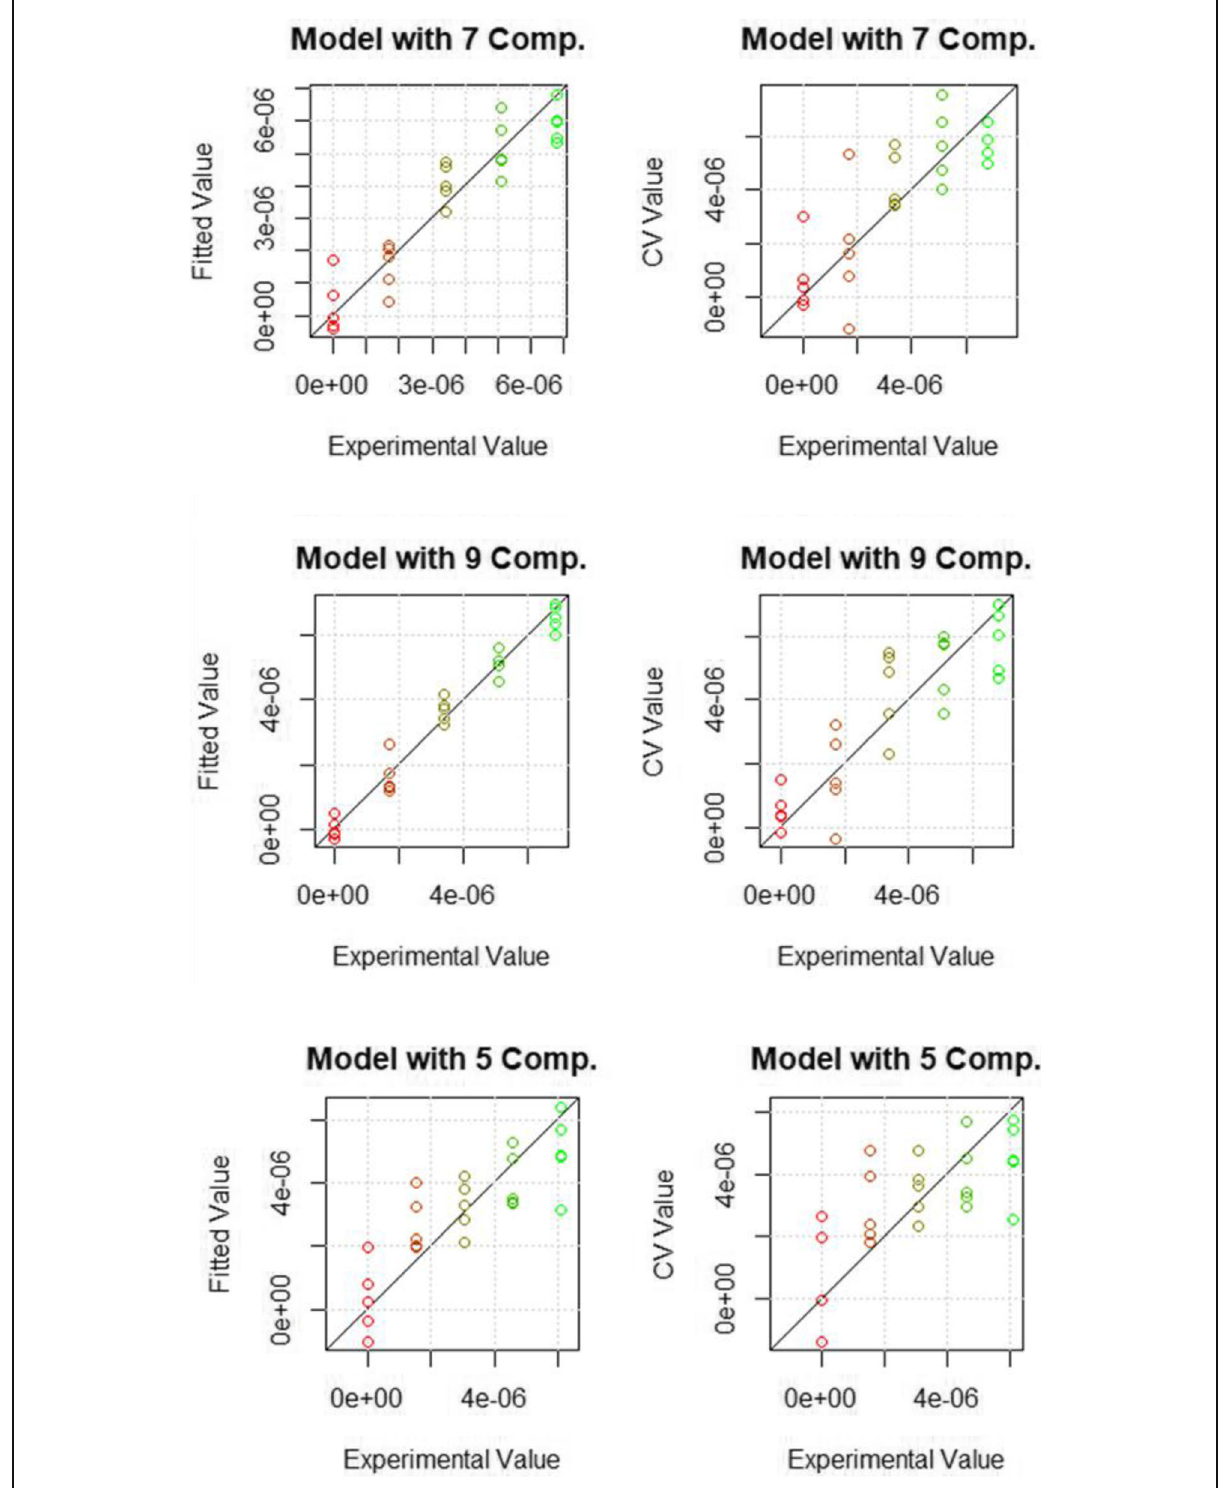
Fig. 7 Software output for the PLS regression model: Co(II), Ni(II), and Zn(II) on the PAN-CC sensor. a Model for Co(II); b model for Ni(II); c model for Zn(II). The different colours refer to five replicates at different metal ion concentration. (1) Comparison of the experimental points with the points recalculated from the model; (2) the same comparison but in the conditions of cross-validation. This plot assesses the variability of the estimated parameters and its effect on the